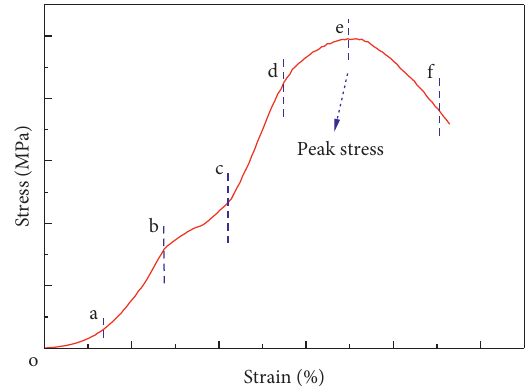
Figure 5: Typical stress-strain characteristic curve of cement-fly